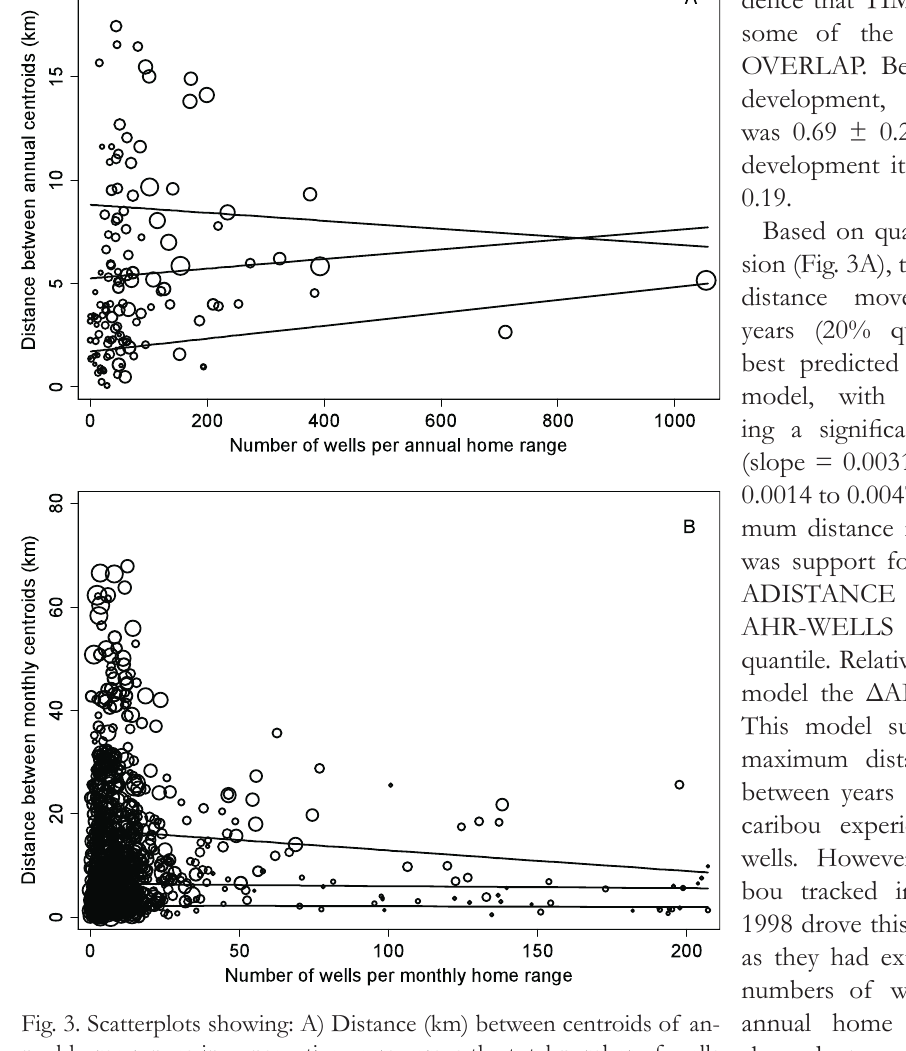
Fig. 3. Scatterplots showing: A) Distance (km) between centroids of an- nual home ranges in consecutive years versus the total number of wells within the annual home range of caribou in year t (AHR-WELL); B) Dis- tance (km) between centroids of monthly home ranges in consecutive years versus the total number of wells within the monthly home range in year t (MHR-WELL) . Lines of best fit indicate maximum (80% quantile), mean, and minimum response (20% quantile). Monthly home range was a circular buffer 4 km in radius. The size of the circles is proportionate to the overall size of the animal’s annual home